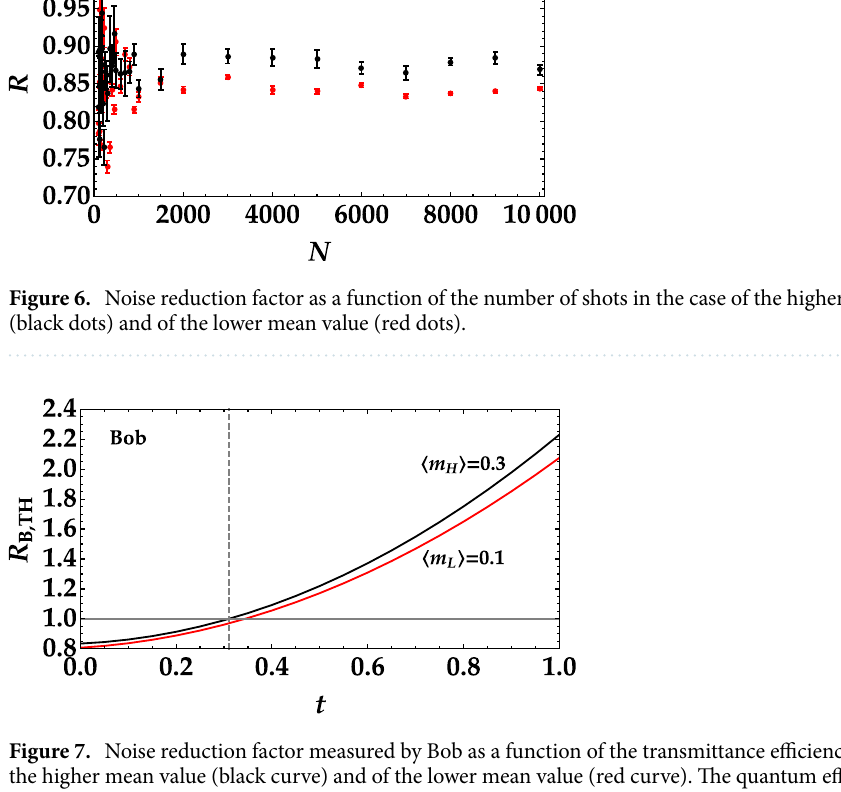
1 represents the = t ∗ , that is the =